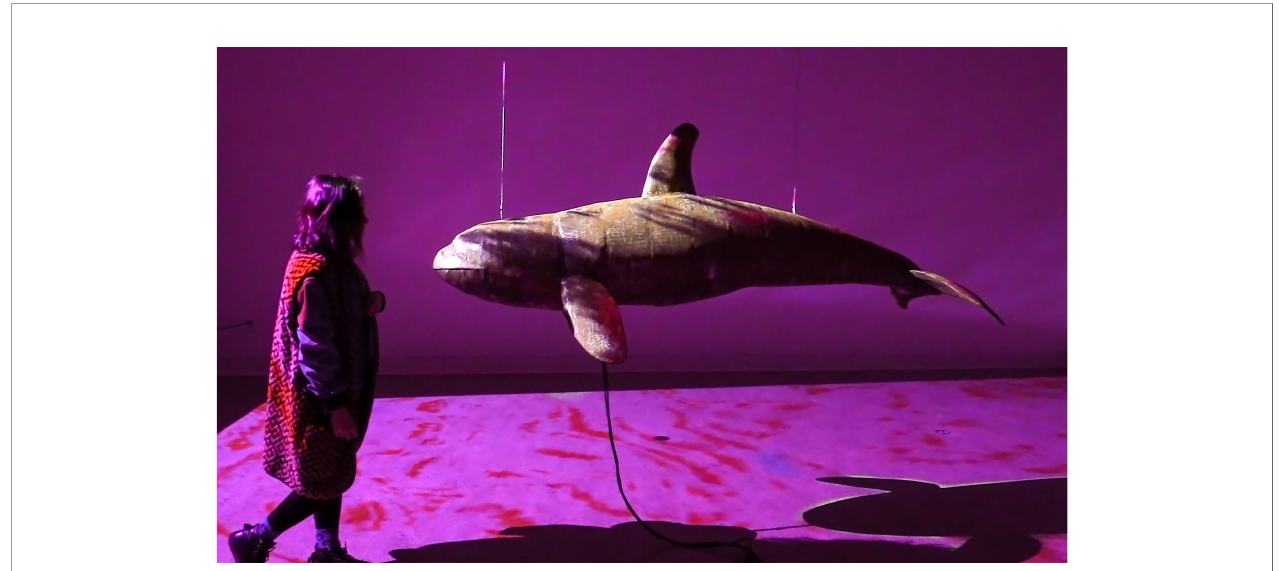
FIGURE 3 | Photo of Resonant Disintegration. A life-size form of an adolescent female orca is suspended, inviting viewers to approach and physically engage with the